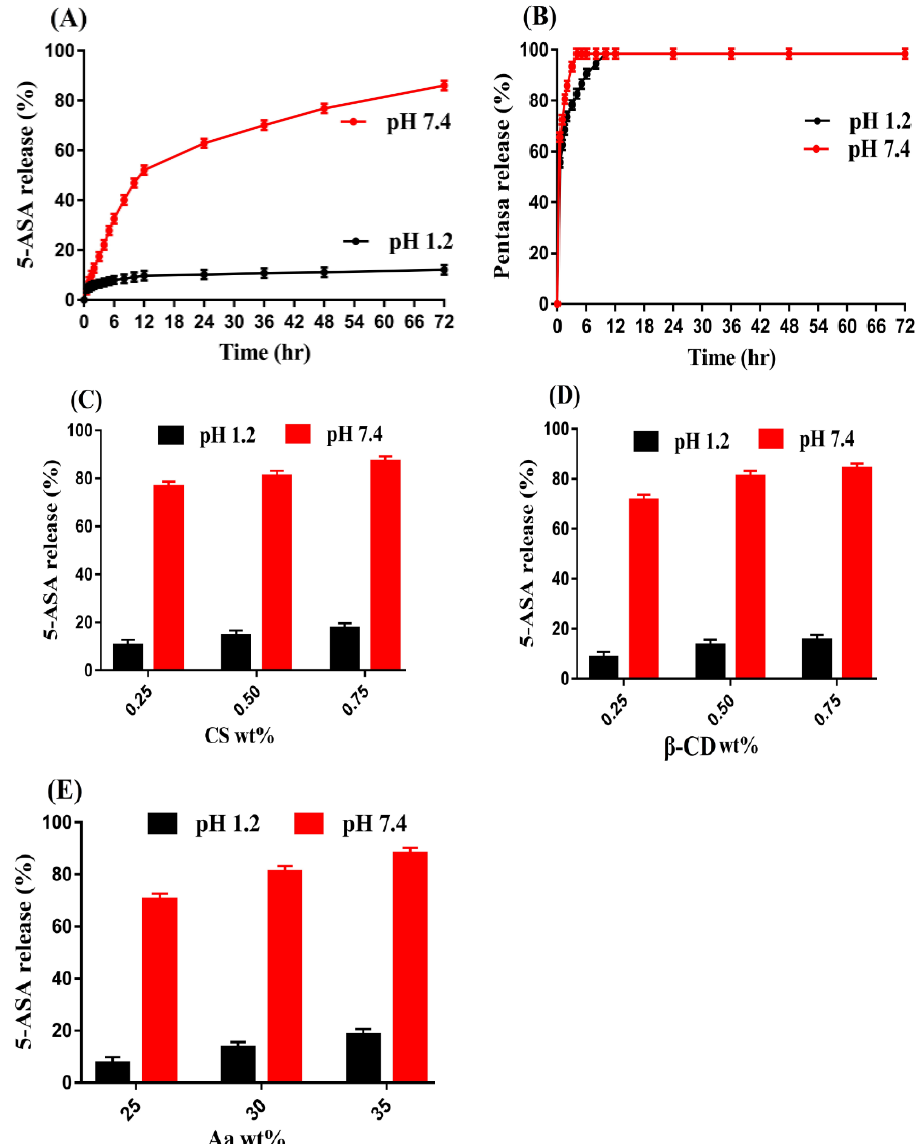
Figure 8. Effect of pH on ( A ) percent drug release from CS/ β -CDcPAa hydrogel, ( B ) percent drug release from Pentasa, and effect of ( C ) CS, ( D ) β -CD, and ( E ) Aa on percent drug release from CS/ β -CDcPAa hydrogel. Table 3. Kinetic modeling release of 5-ASA from CS/ β -CDcPAa hydrogels. F.